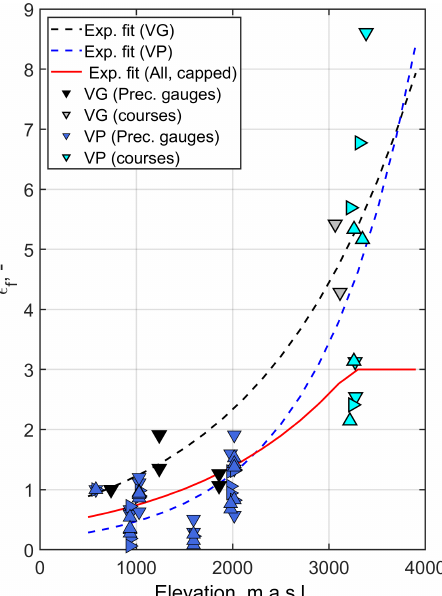
Figure 6. Orographic enhancement factors (cid:15) f for Beauregard (VG) and Valpelline (VP) across all water years as estimated using pre- cipitation gauges (blue and black) and snow courses (gray and light blue). The dashed lines are exponential fits between orographic en- hancement factors and elevation, while the red line is a capped ex- ponential fit that was chosen to be implemented in Flood-PROOFS (Eq. 1). Details on this choice are reported in Sect. 4.3, while details on Flood-PROOFS are reported in Sect. 3. Enhancement factors are the ratio between winter cumulative precipitation measured by gauges or estimated through snow courses above 3000ma.s.l. and precipitation measured by the lowest elevation gauge in the same valley. The orientation of the triangles relates to the classification of each water year in terms of mean snow depth (see Fig.